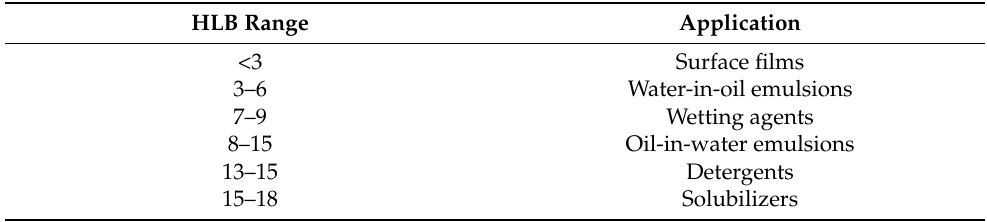
Table 2. Applications and Corresponding HLB Values. Adapted from refs.